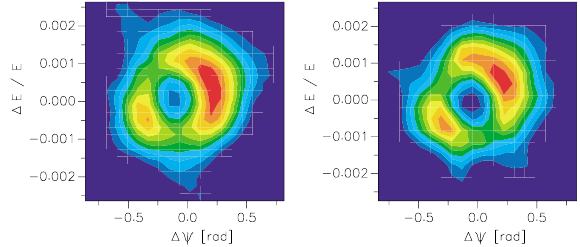
FIG. 2. (Color) Comparison of tomographic reconstructions of a bunch that has been destroyed by a fast instability. The left-hand graph depicts the result obtained by the code described in this paper, while the right-hand one shows the corresponding plot using the CERN code